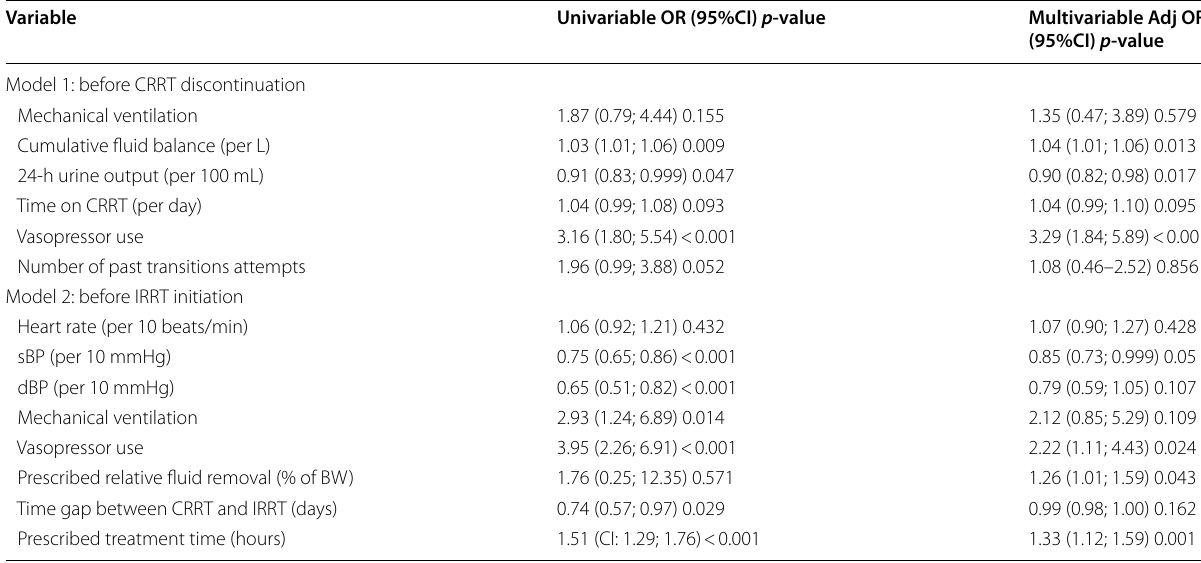
Associations were assessed using generalized estimating equations with a binary logistic link function and using an M‑estimator with an independent correlation